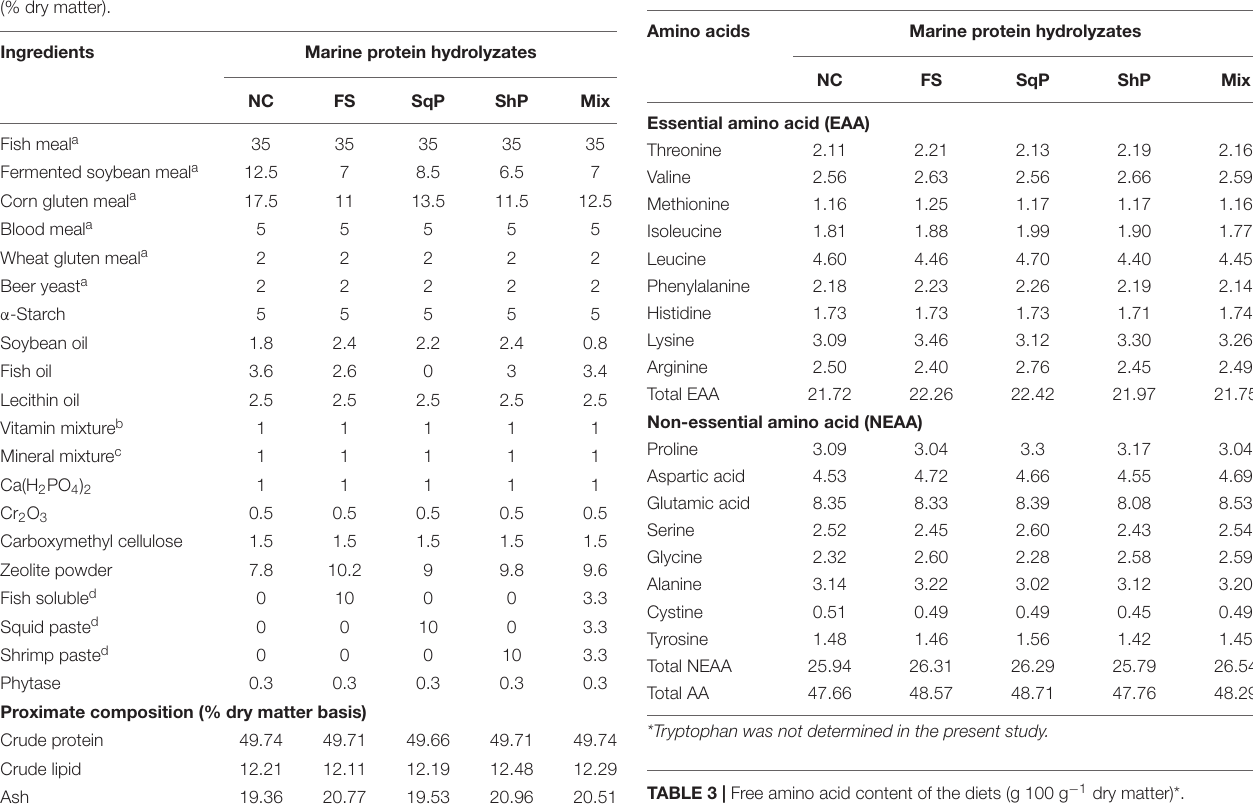
TABLE 2 | Amino acid content of the diets (g 100 g − 1 dry